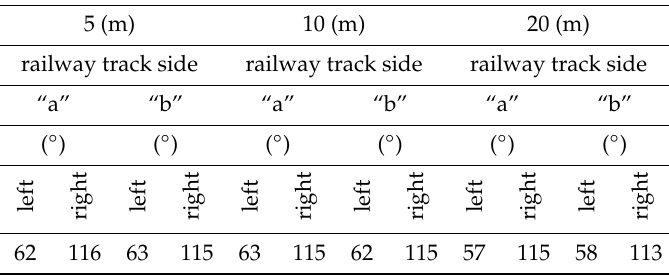
Table 6. Geometric angular values of existing conditions of train front visibility from the road for track